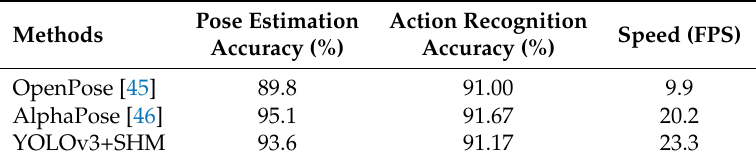
Table 6. Comparing the effects of different pose estimation